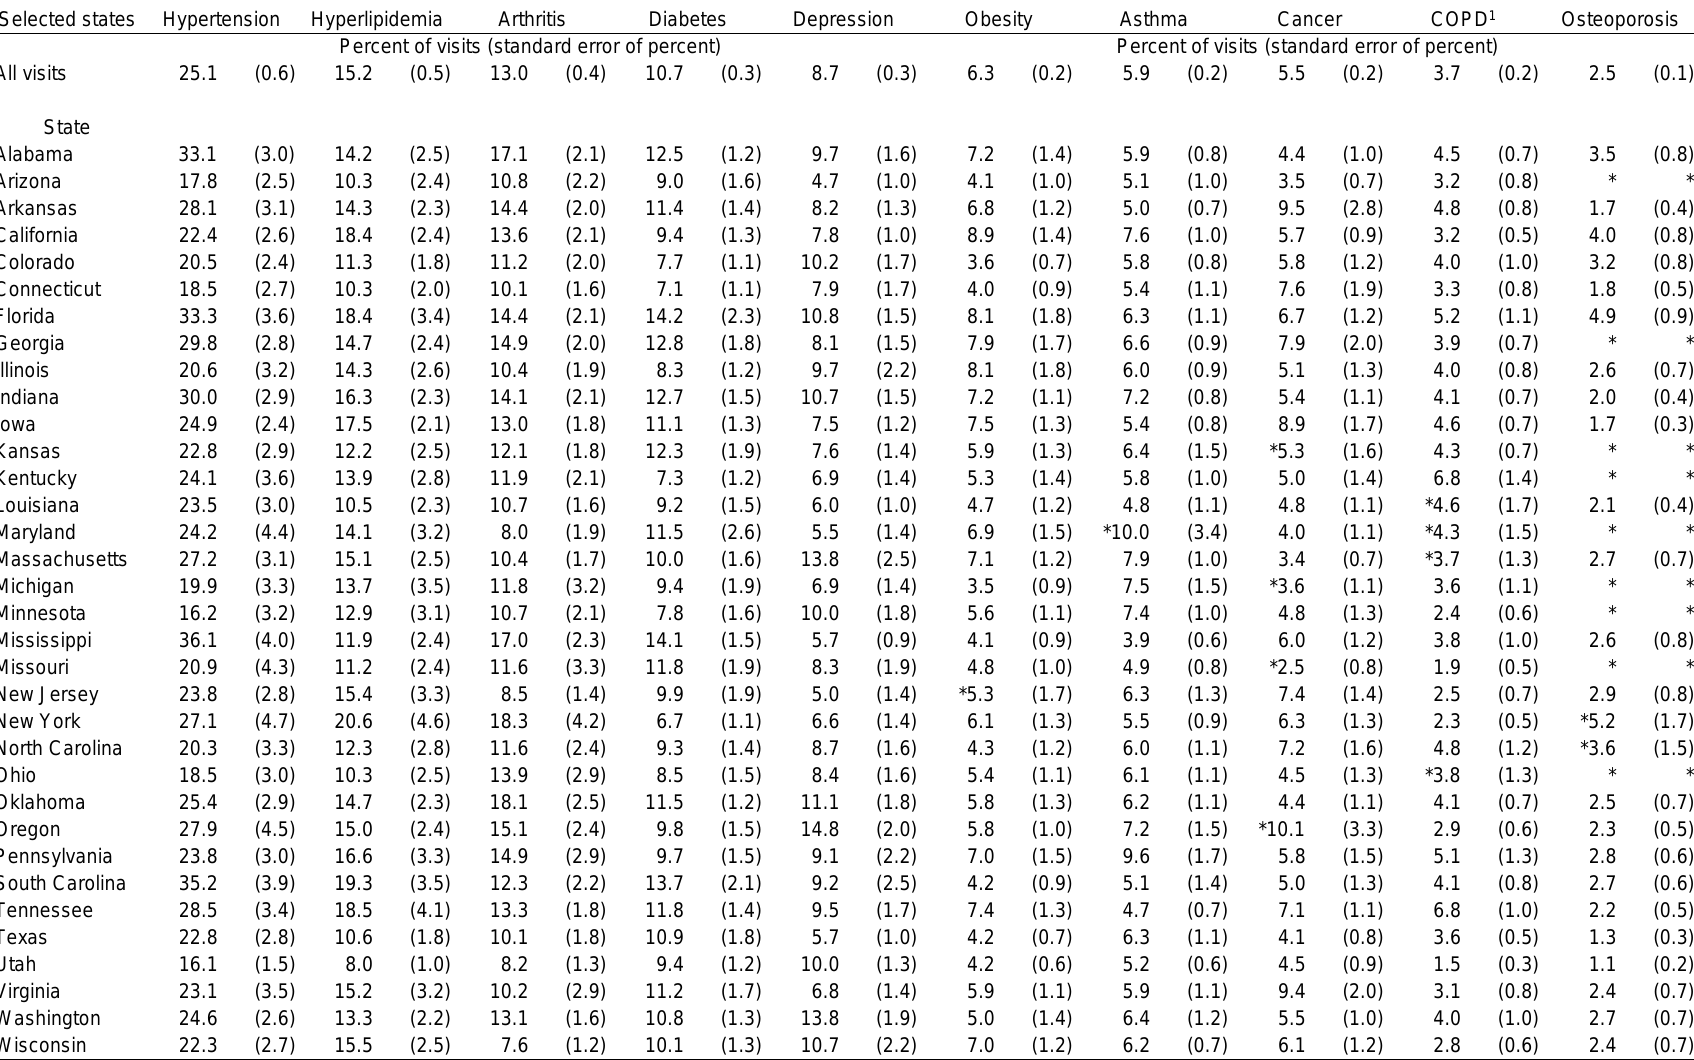
*Figure does not meet standards of reliability or precision 1 COPD is chronic obstructive pulmonary disease. SOURCE: CDC/NCHS, National Ambulatory Medical Care